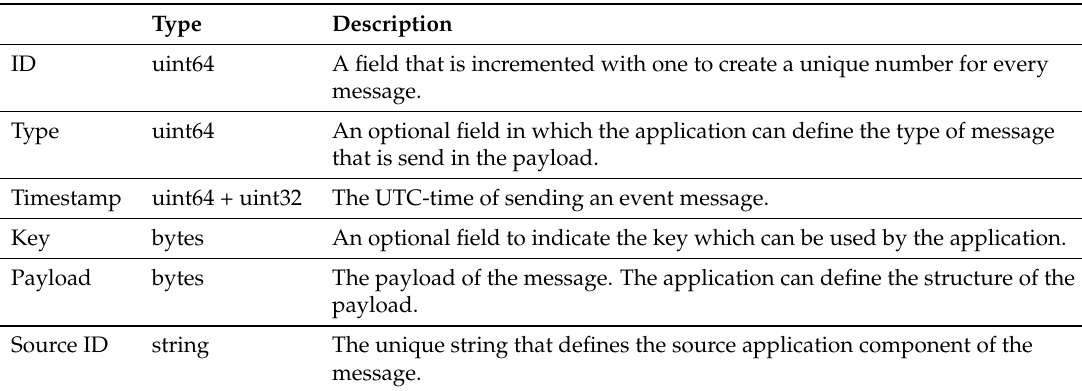
Table 1. The DUST Message data